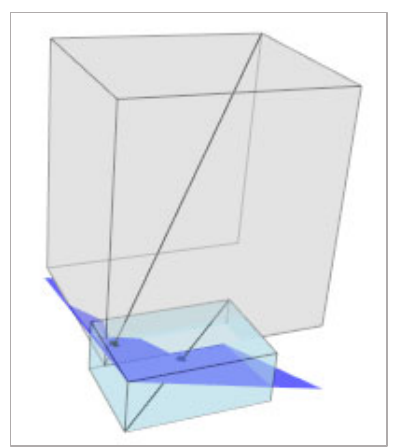
Fig. 1. The two hypercube achieved by the prior model and the new proposed